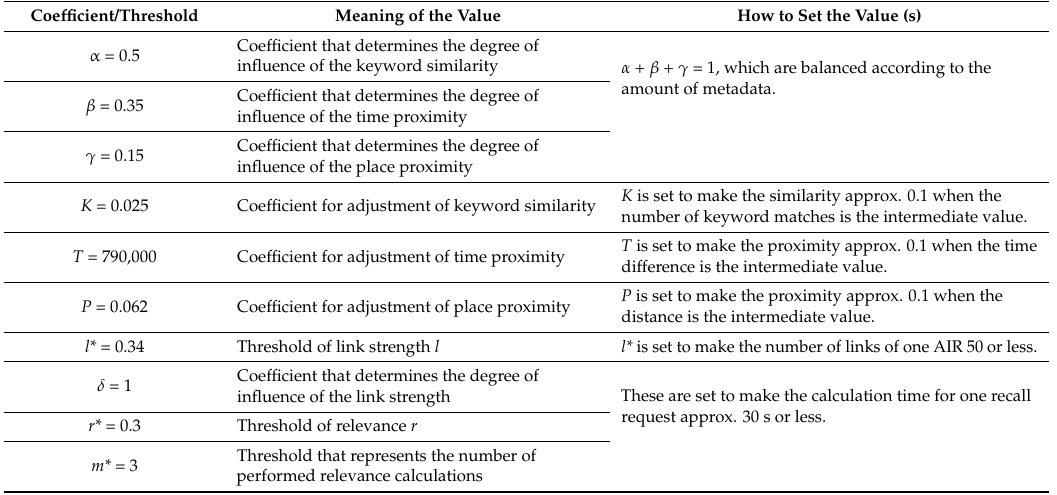
Table 6. Coefficient and threshold used in the